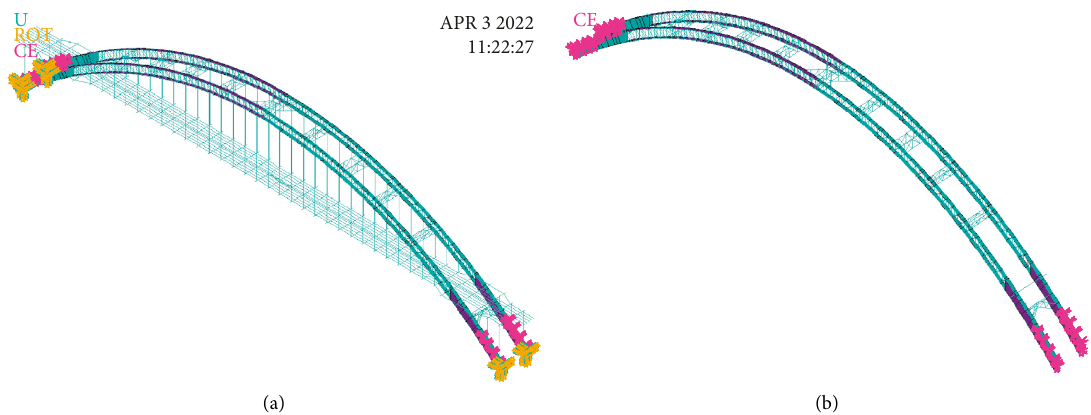
Figure 22: The 3D finite element model of the full bridge: (a) The full bridge and (b) the main arch ring.